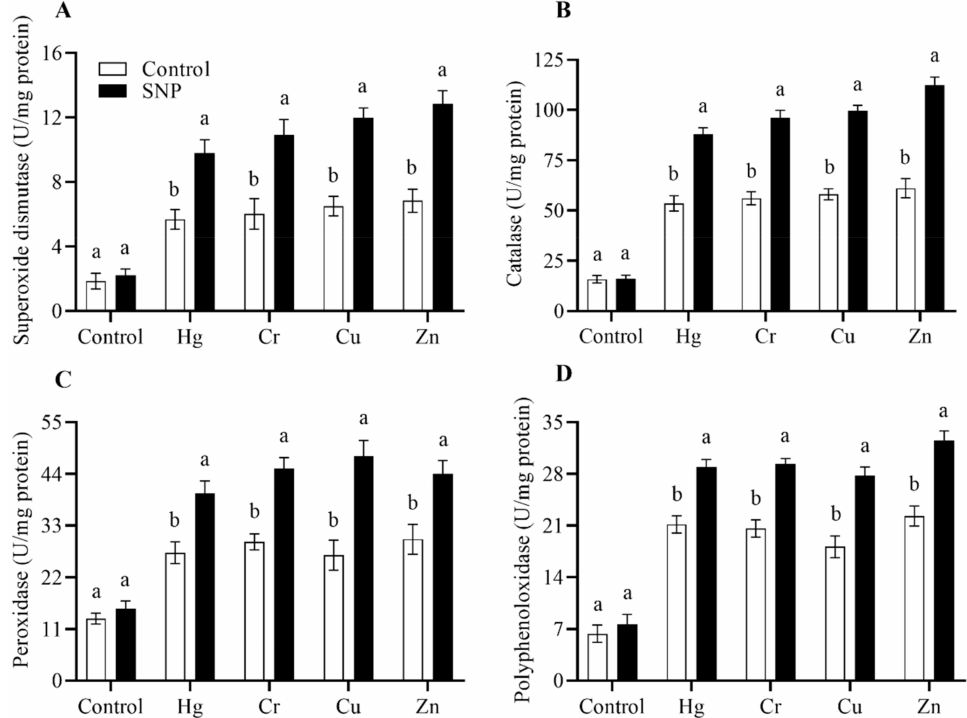
Figure 4. Effects of exogenously applied SNP on rice with or without Hg-, Cr-, Cu-, and Zn-induced stress on rice plants. ( A ) Superoxide dismutase, ( B ) catalase, ( C ) peroxidase, ( D ) polyphenol oxidase. Each data point indicates the mean ± standard deviation ( n = 3). Bars with different letters indicate significant differences, according to Duncan’s multiple range test. The results are compared to the respective controls (Hg-, Cr-, Cu-, and Zn-untreated and Hg-, Cr-, Cu-, and Zn-treated